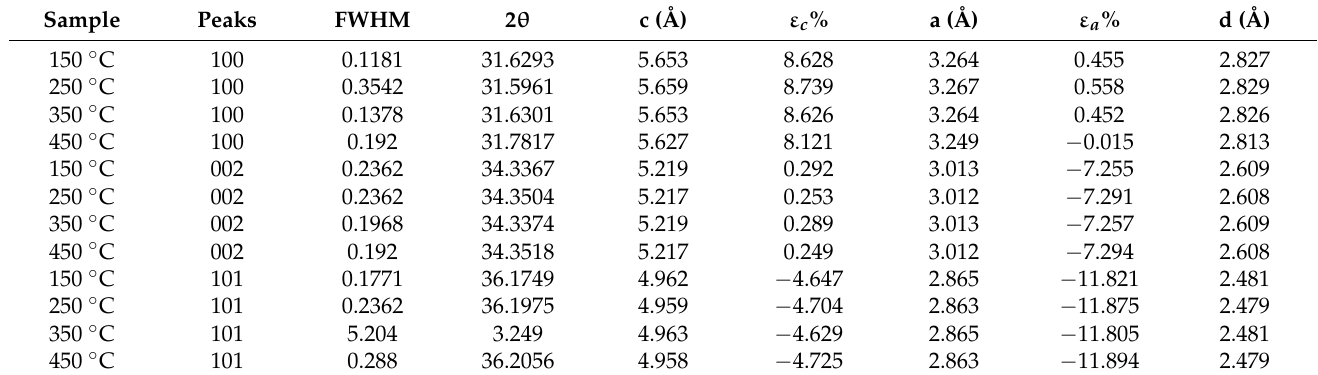
Table 2. Lattice parameters of ZnO wurtzite–hexagonal structure characteristics at stronger diffraction peaks for the (100), (002), and (101) planes of the ZnO nanoparticles synthesized at different calcination